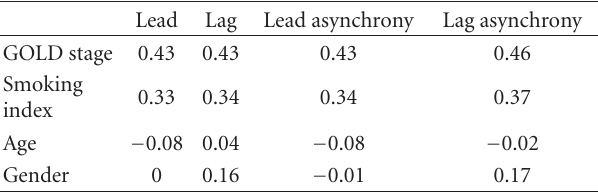
Table 5: Correlation of lead and lag with clinical